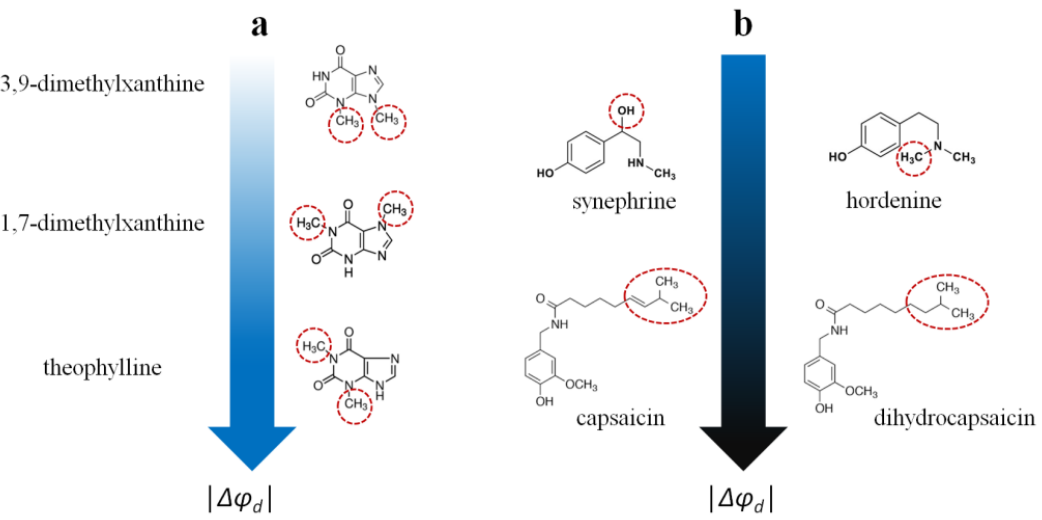
Figure 6. The relationships between the structure of alkaloids and their dipole-modifying ability. ( a ) The dependence of dipole-modifying ability of xanthines on the localization of the methyl groups; ( b ) The independence of dipole-modifying effect of protoalkaloids on the presence of OH-group and the double bond in the side chain of phenylethylamines and benzylamines respectively (from top to bottom). The color intensity designation is shown in the caption of Figure 5.